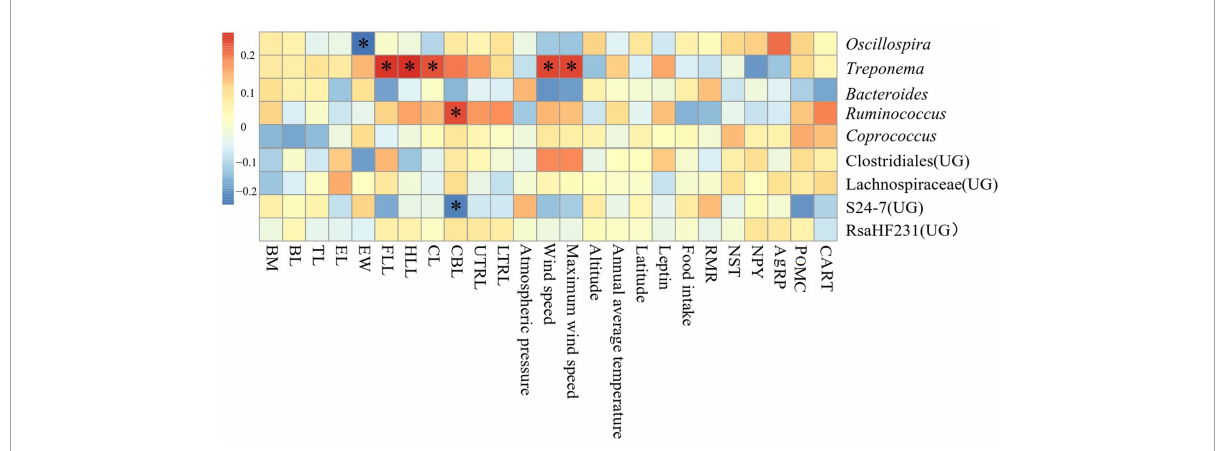
FIGURE7 Heat map of environmental physicochemical properties in different regions related to the dominant microorganisms in Eothenomys miletus.